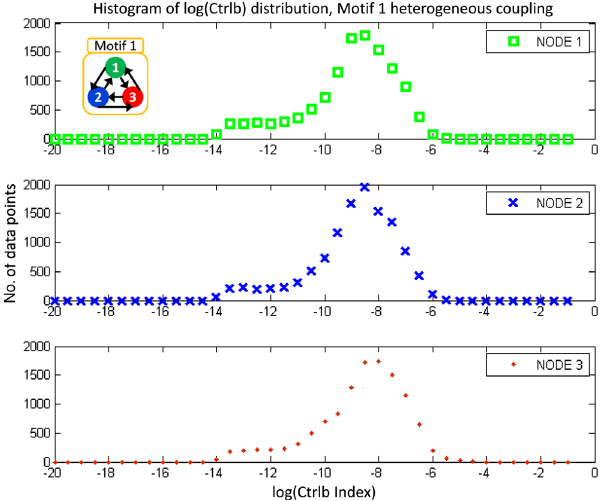
FIG. 9. Histogram of the log-scaled controllability indices for motif 1 with heterogeneous coupling and chaotic